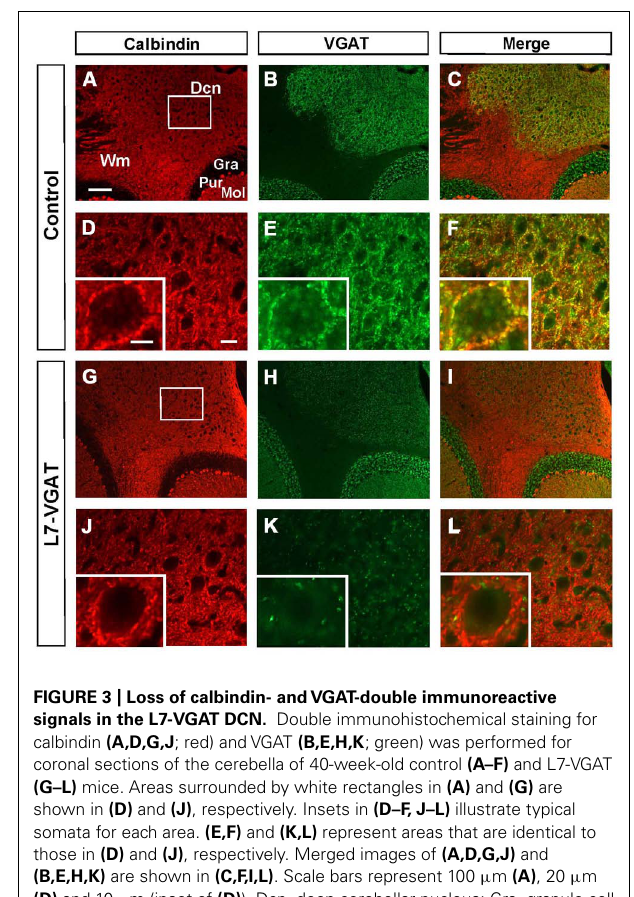
FIGURE 3 | Loss of calbindin- andVGAT-double immunoreactive signals in the L7-VGAT DCN. Double immunohistochemical staining for calbindin (A,D,G,J ; red) andVGAT (B,E,H,K ; green) was performed for coronal sections of the cerebella of 40-week-old control (A–F) and L7-VGAT (G–L) mice. Areas surrounded by white rectangles in (A) and (G) are shown in (D) and (J) , respectively. Insets in (D–F, J–L) illustrate typical somata for each area. (E,F) and (K,L) represent areas that are identical to those in (D) and (J) , respectively. Merged images of (A,D,G,J) and (B,E,H,K) are shown in (C,F,I,L) . Scale bars represent 100 μ m (A) , 20 μ m (D) and 10 μ m (inset of (D) ). Dcn, deep cerebellar nucleus; Gra, granule